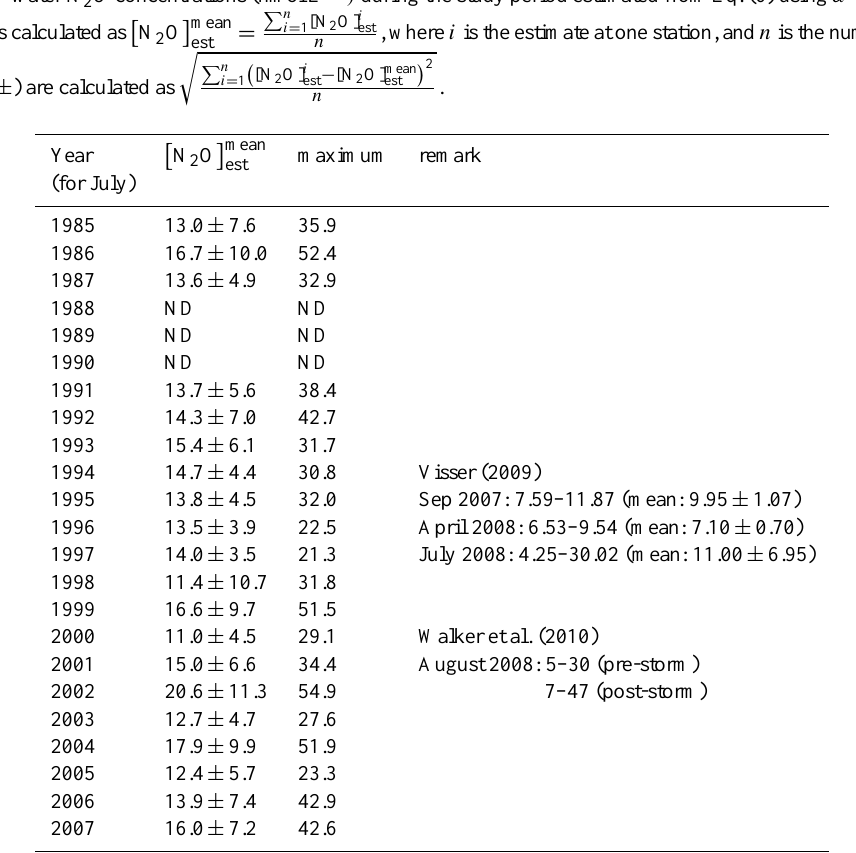
P n i = est i = 1 [N 2 O] , where i is the estimate at one station, and n is the number of total estimates. n est